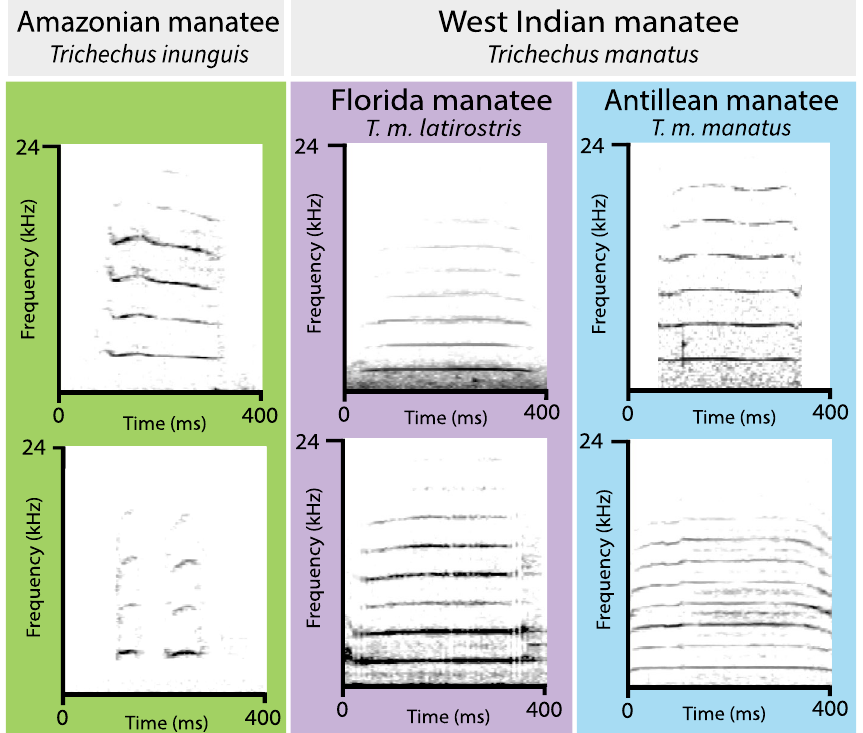
Figure 2. Spectrograms of vocalizations recorded from individual calves in this study from the Amazonian manatee ( Trichechus inunguis ) and the two subspecies of the West Indian manatee ( T. manatus )—the Antillean manatee ( T. m. manatus ) and the Florida manatee ( T. m. longirostris